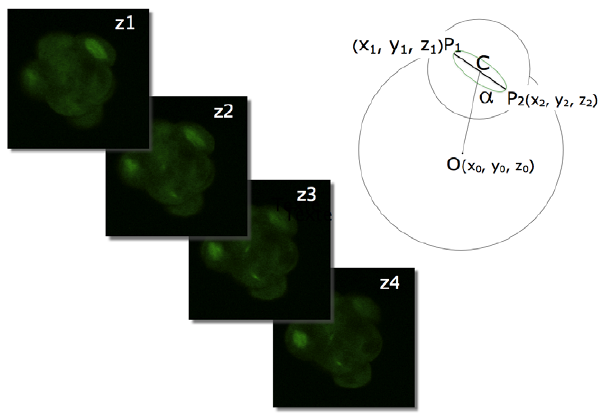
Figure 1. Determination of spindle poles and embryo centre coordinates. For a given spindle, the position of three points were determined, by moving through the stack of images (z1, z2, z3, …): the two poles of the spindle (P1 and P2) and the centroid of the embryo (O). The position of the centre of the spindle (C) and the value of the a angle were calculated using the coordinates of these 3